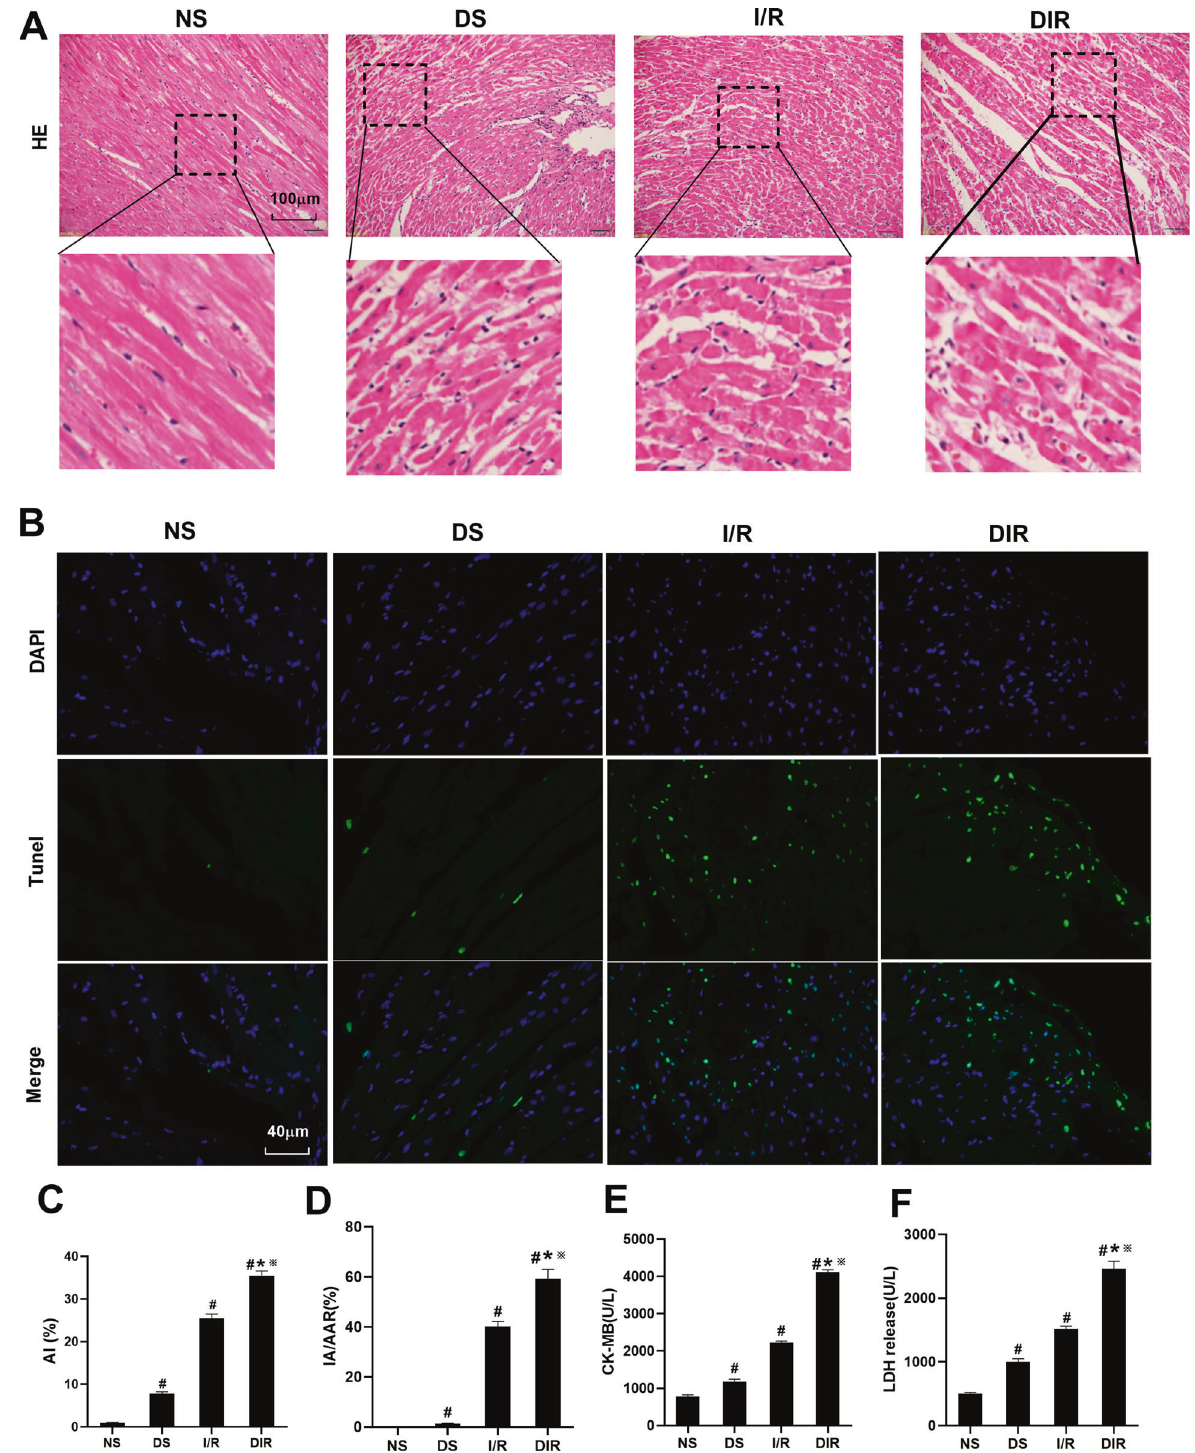
Fig. 1 DS, I/R, and DIR rat models construction and veri fi cation. A Histopathological changes of myocardium were detected by HE staining. B , C The TUNEL staining for cell apoptosis rates were detected in different rat groups. D The myocardial infarction area was detected and expressed by AI/AAR (%). E CK-MB in serum was detected. F LDH in serum was detected. Results are presented by means ± SD. n = 8 per group. # P < 0.05 compared with the NS group. * P < 0.05 compared with the DS group. ※ P < 0.05 compared with the I/R compared with the NS group, the level of Fe 2 + and ROS was The level of DNMT-1 and ferritinophagy-ferroptosis axis in DS, I/R and DIR rats increased in DS, I/R, and DIR group ( P < 0.05). Compared with DS Subsequently, we veri fi ed the levels of ferroptosis, ferritinophagy, and I/R group, the level of Fe 2 + and ROS was further increased in and DNMT-1 in DS, I/R, and DIR rat models. As shown in Fig. 2A, B, the DIR group ( P < 0.05). As shown in Fig. 2C – E, compared with the